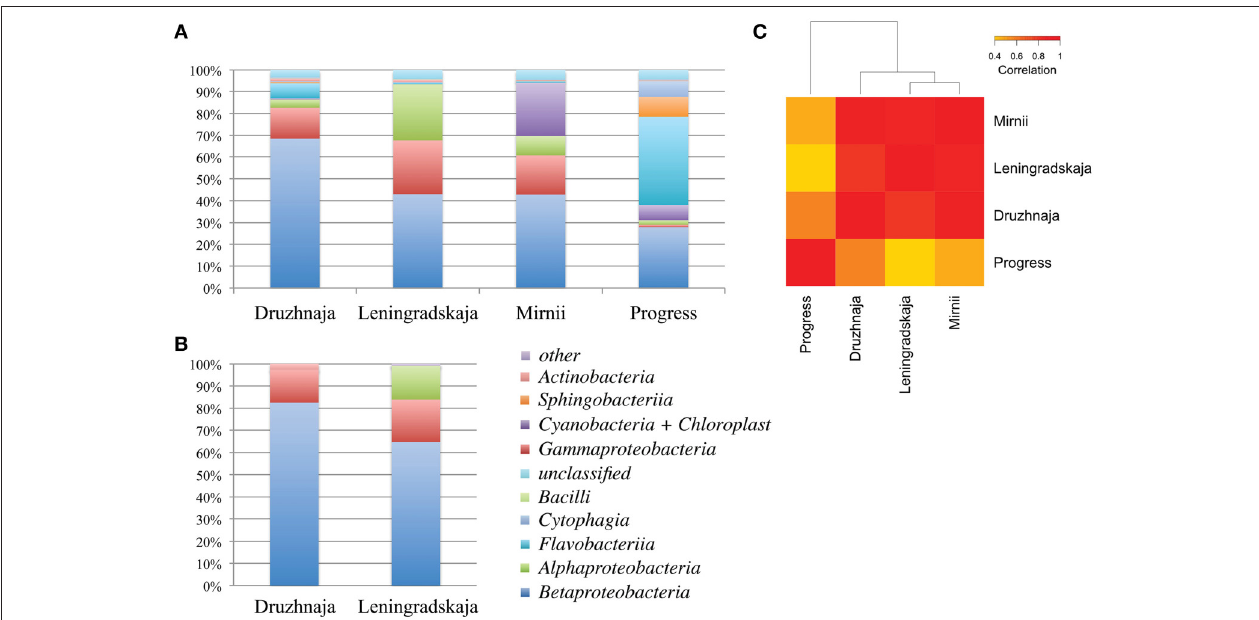
FIGURE 2 | Class-level bacterial diversity in Antarctic snow samples. (A) Relative abundance of class-level bacterial taxonomies based on PCR amplifications and high-throughput sequencing of 16S rRNA gene fragments is shown at the top. “Other” group includes minor classes with < 0.6% of total abundance, namely Verrucomicrobiae , Clostridia , Gemmatimonadetes , Planctomycetia , Deltaproteobacteria , Spartobacteria , Epsilonproteobacteria , and 14 rare classes found only in one location. (B) Similar data using clone library approach for same samples from Druzhnaja and Leningradskaja stations are shown. (C) A heatmap comparing class-level bacterial diversity and abundance among the four samples based on high-throughput sequencing results. The colors show the extent of relatedness between the samples as indicated in the